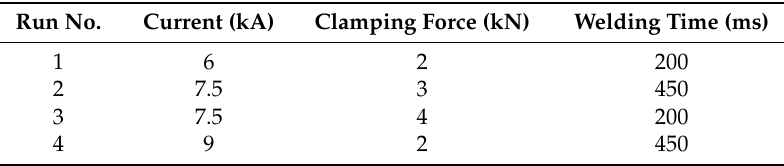
Table 3. Settings of the joining parameters employed in the welding tests.